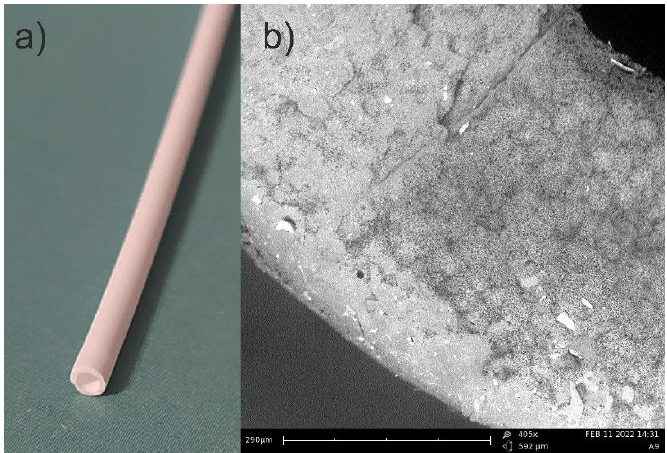
Figure 2. Picture of PP capillary hollow fiber: ( a ) photo; ( b ) SEM picture (note some openings with a diameter of 0.2–0.3 µ